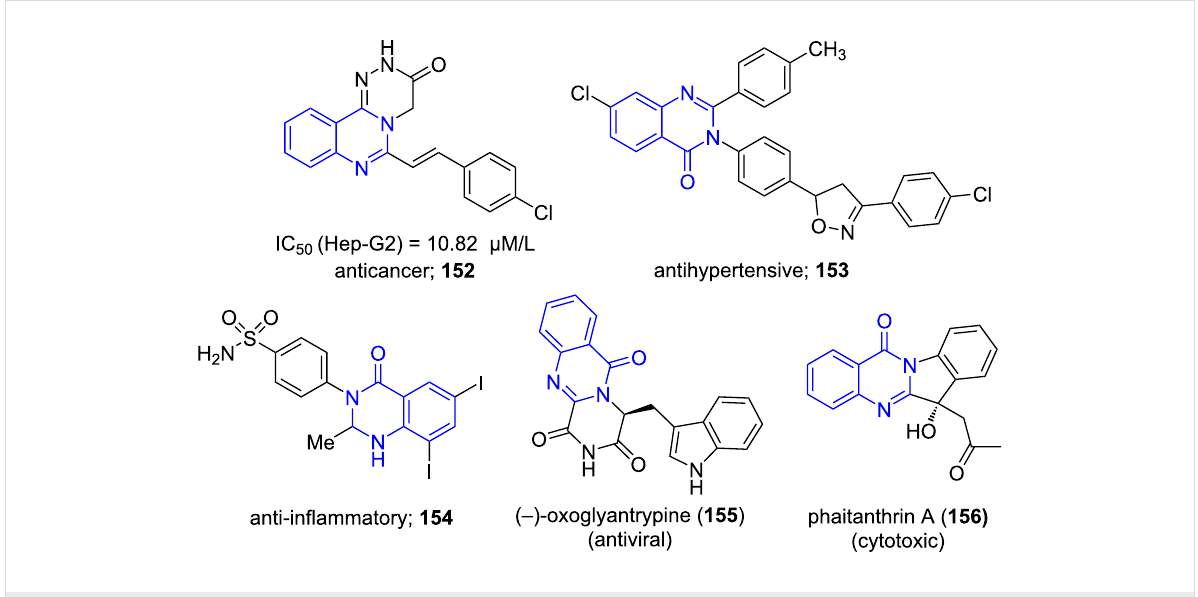
Figure 12: Quinazolinones as pharmacologically significant scaffolds.